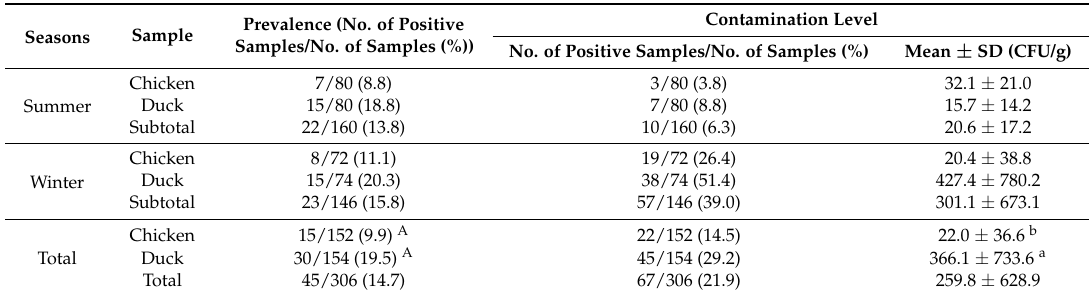
Table 3. Prevalence and contamination levels of Campylobacter in chicken and duck carcasses at wet markets in Korea during summer and